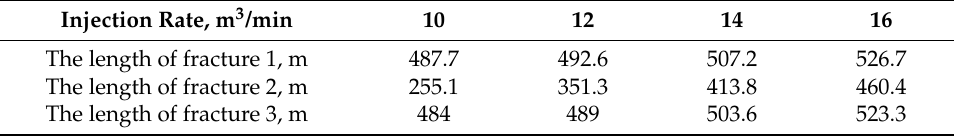
Figure 7. Effects of different injection rates on the fracture geometry: ( a ) 10 m 3 /min; ( b ) 12 m 3 /min; ( c ) 14 m 3 /min; and ( d ) 16 m 3 /min. Table 4. The results of fracture length affected by different injection rates.